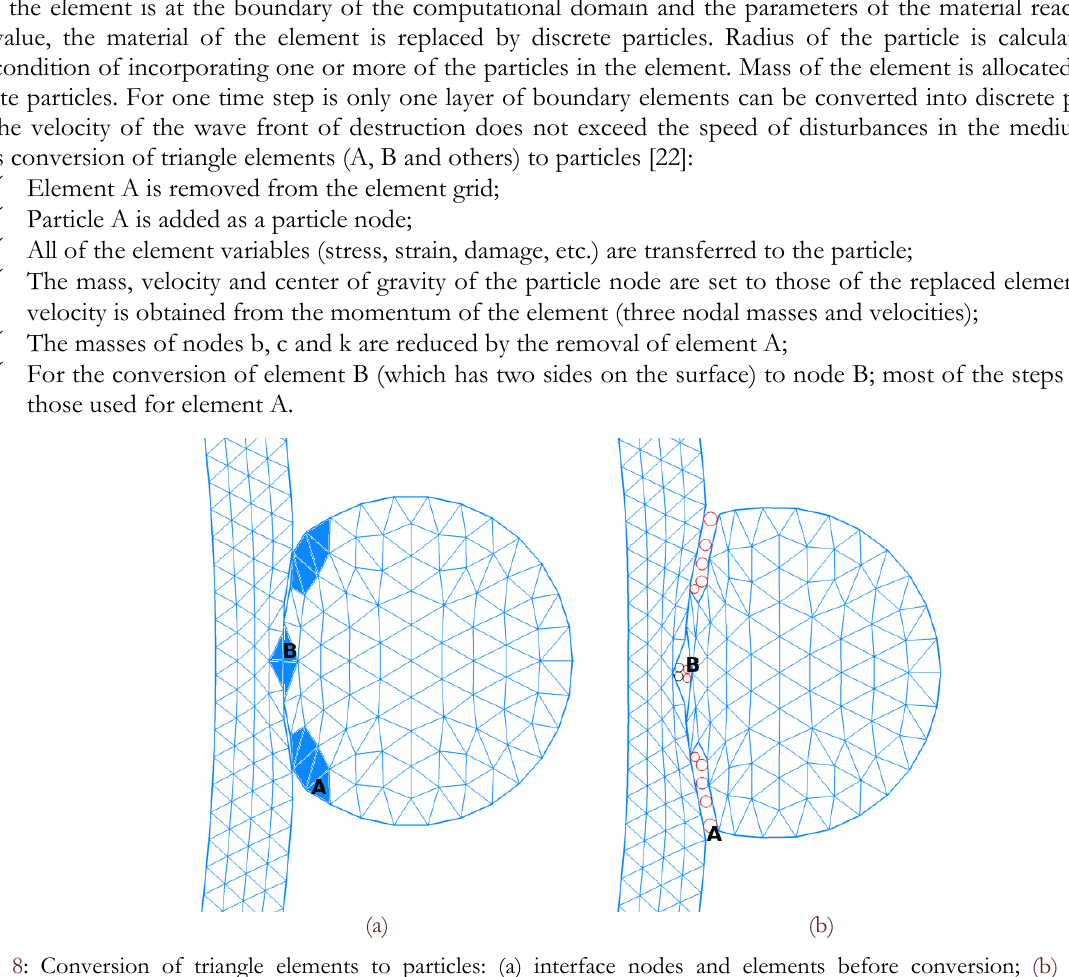
Figure 8: Conversion of triangle elements to particles: (a) interface nodes and elements before conversion; (b) interface after conversion of